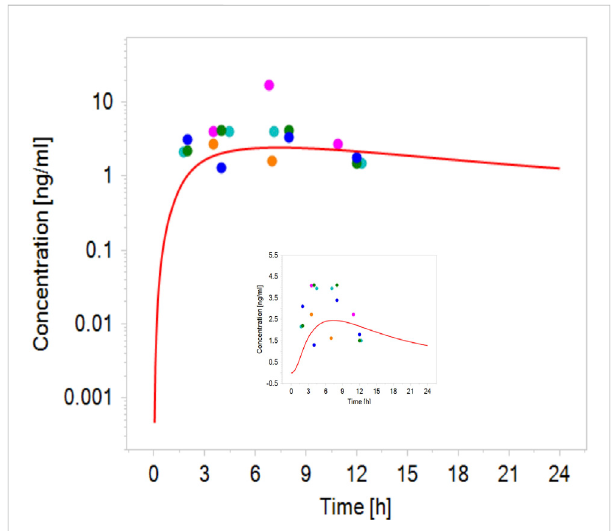
FIGURE 2 Simulated(line) concentration – time pro fi le of CPF following oral administration of 2 mg/kg bw compared with the observed plasma concentration – time data in volunteers administered oral CPF at a